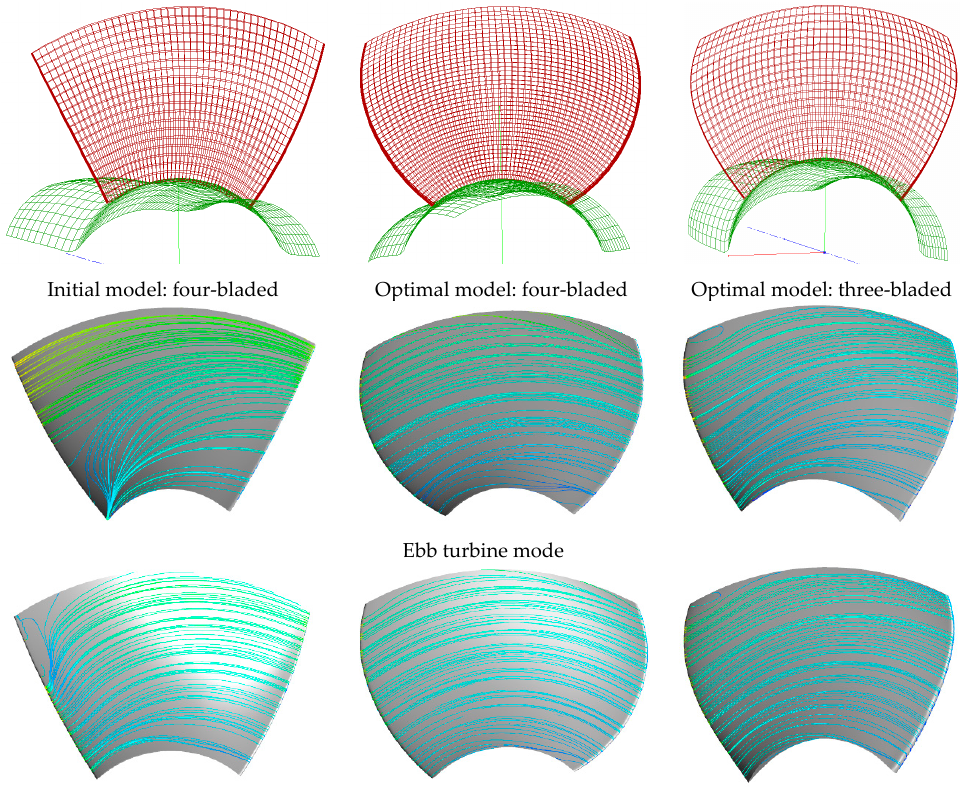
Figure 5. Streamlines on the suction side of the blades at the optimum point.